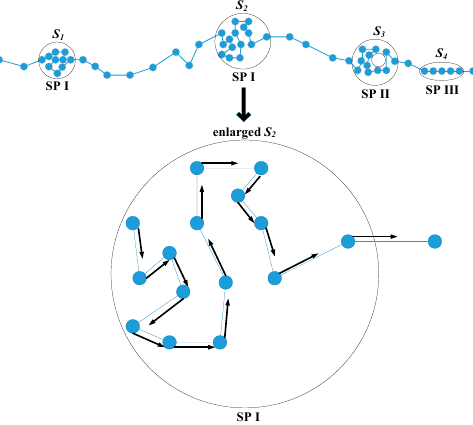
Figure 3. Three kinds of stay places within a trajectory. The direction change can be clearly seen in the enlarged S 2 .